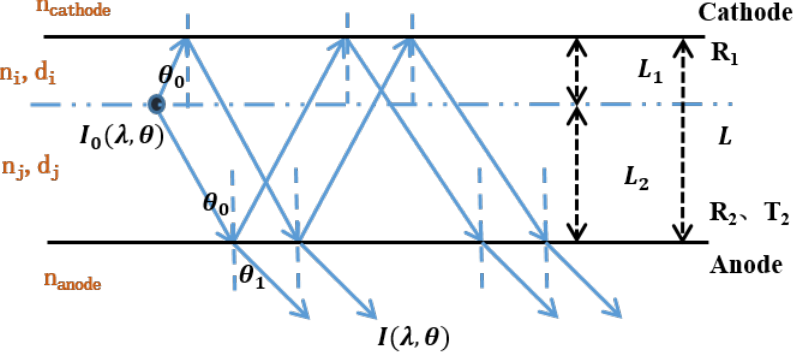
Figure 2. Micro-cavity OLEDs schematic.